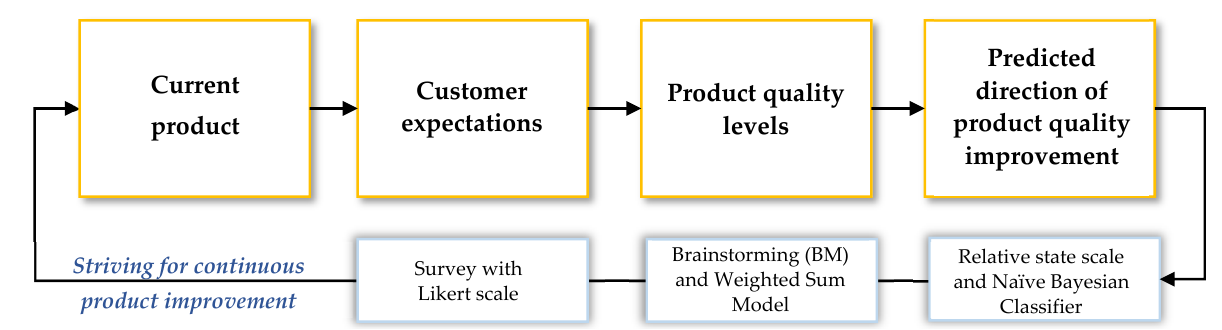
Figure 1. General concept of model. Own study.